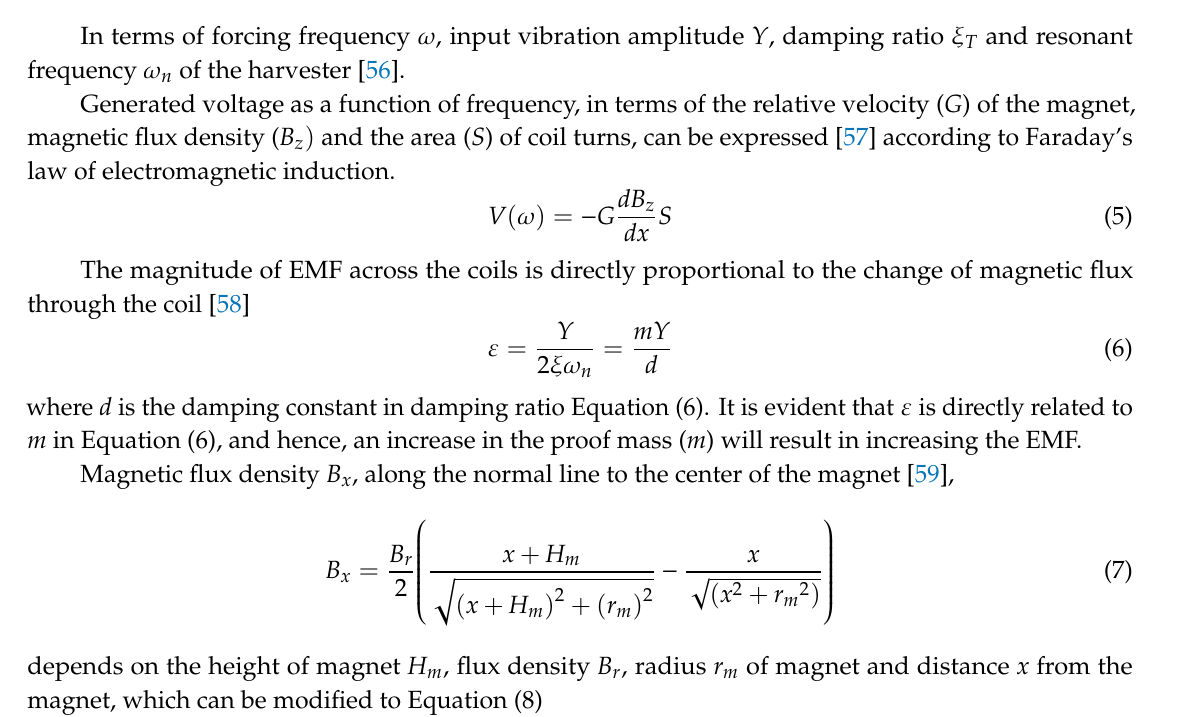
Figure 3. Mass-spring-damper model of the hybrid insole energy harvester.